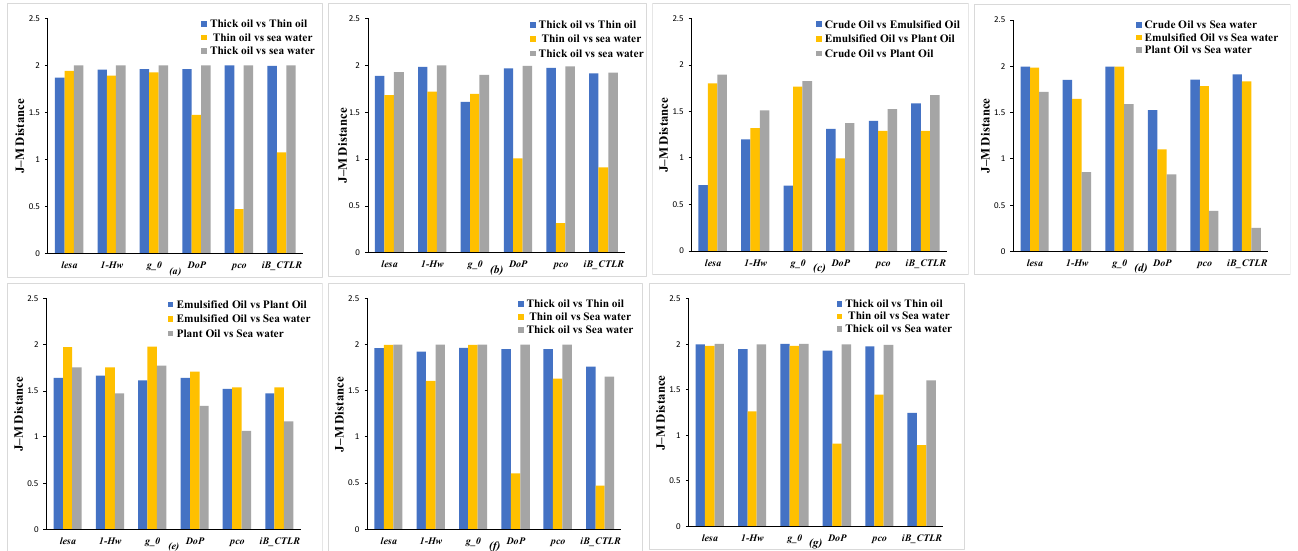
Figure 13. JM distance measurement results: ( a ) Case 1; ( b ) Case 2; ( c , d ) Case 3; ( e ) Case 4; ( f ) Case 5; ( g ) Case 6.